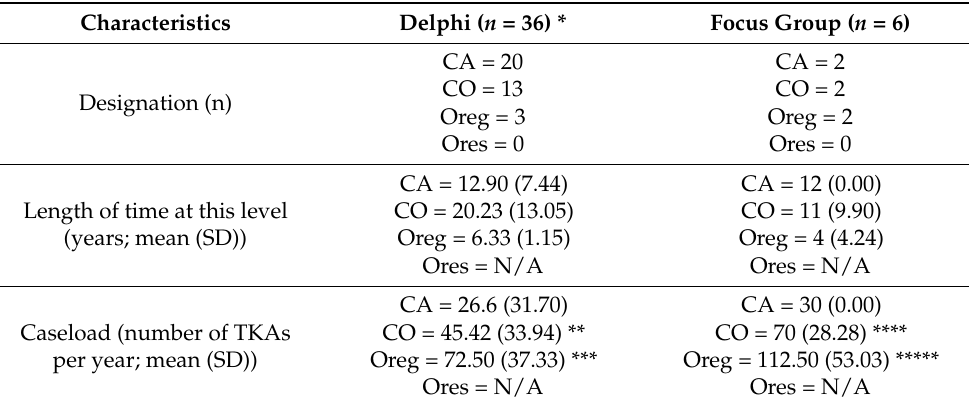
Table 1. Survey and focus group participant